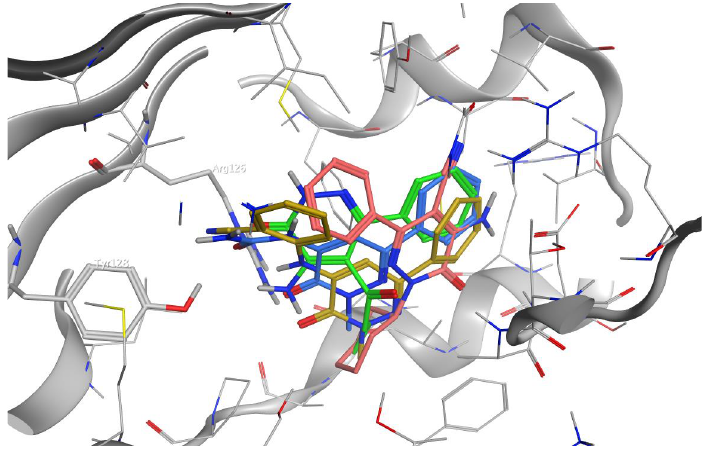
Figure 4. Docked poses inside FABP4 of molecules 4b (green), 25a (blue), 30b (dark yellow) and 22 (light